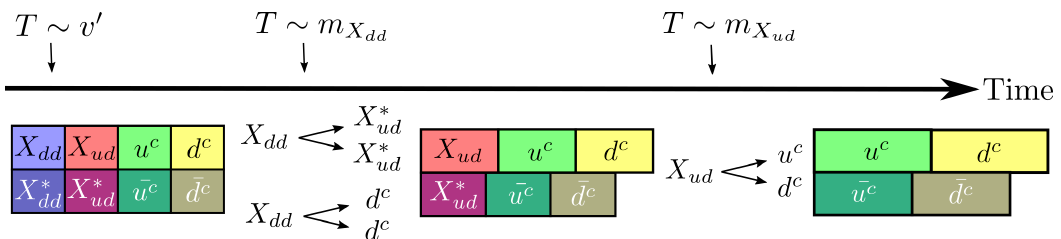
Figure 9 . A timeline (not to scale) that describes the chronology of events in the baryogenesis mech- anism discussed in this section. Before the time of B − L symmetry breaking ( T & v 0 ), the particle species X , X , u c and d c , as well as their corresponding antiparticles, are in thermal and chemical dd ud equilibrium. When X ( ∗ ) has decayed away ( T . m ), an asymmetry has emerged in the relative X dd dd number densities of X , u c , d c with their antiparticles. In the subsequent decay of X ( ∗ ) ud ), this asymmetry is translated into a baryon asymmetry of the Universe stored in SM quarks. m X ud